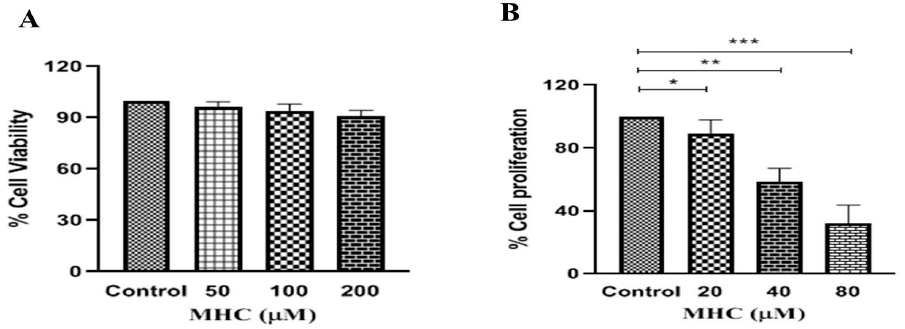
Figure 4. ( A ) MHC-mediated non-cytotoxic effects against human-lung WI38 cells post-MHC treatment after 24 h and ( B ) the effect of MHC in impeding the proliferation of MCF-7 cells as per the observations of the BrdU assay. * p < 0.05, ** p < 0.01 and *** p < 0.001.